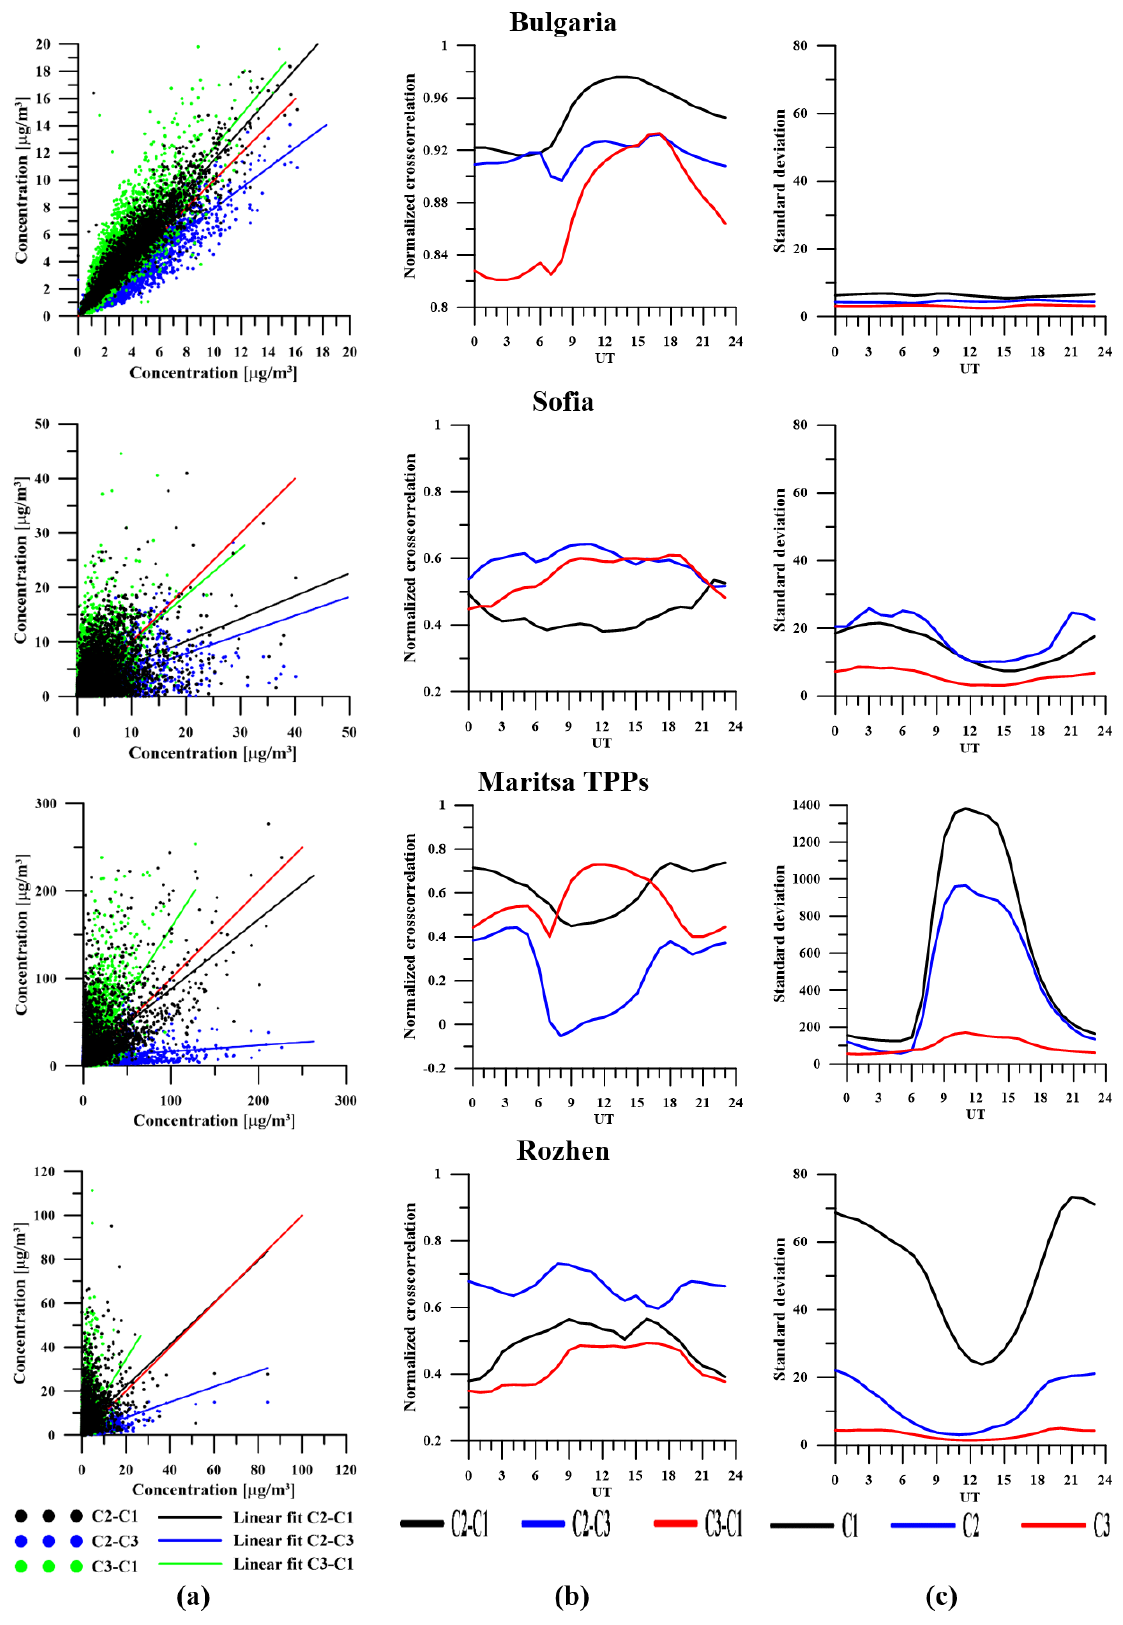
Figure 11. Comparisons of the regression ( a ) and correlations ( b ) and standard deviation ( c ) for SO 2 for the three cases.